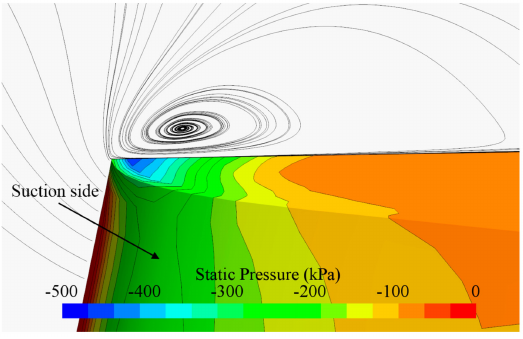
Figure 12. Pressure contours on the tip surface and streamlines in the tip clearance. Q = 0.42 m 3